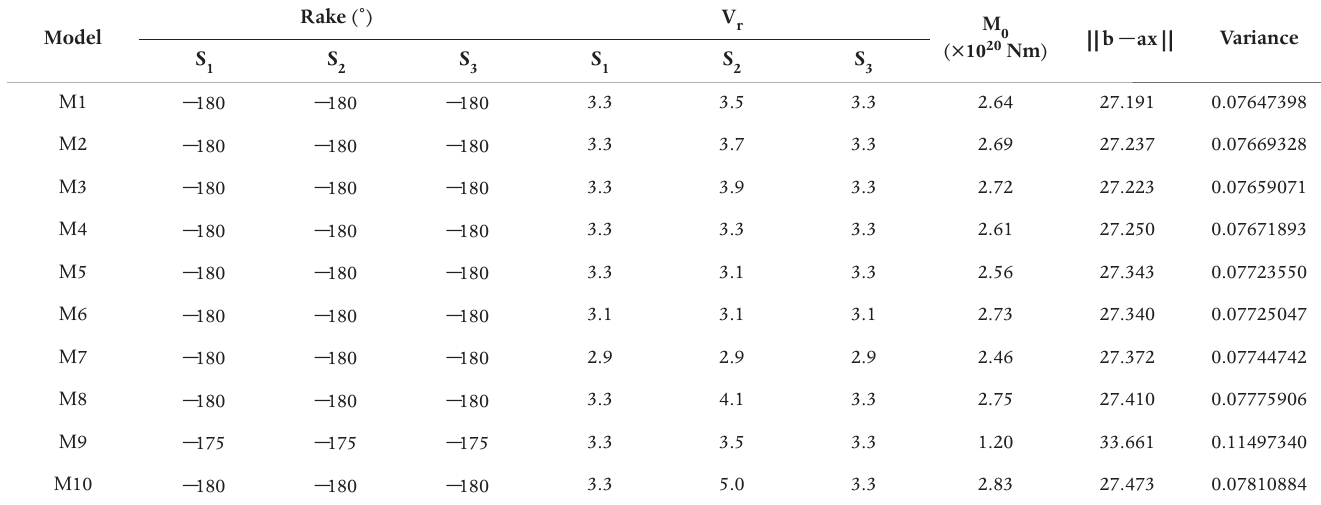
Table 3. Finite-fault inversion trials carried out in the modeling of the August 17, 1999, İ zmit earthquake. Note that the model M1 trial gives the minimum misfit error and residual variance.